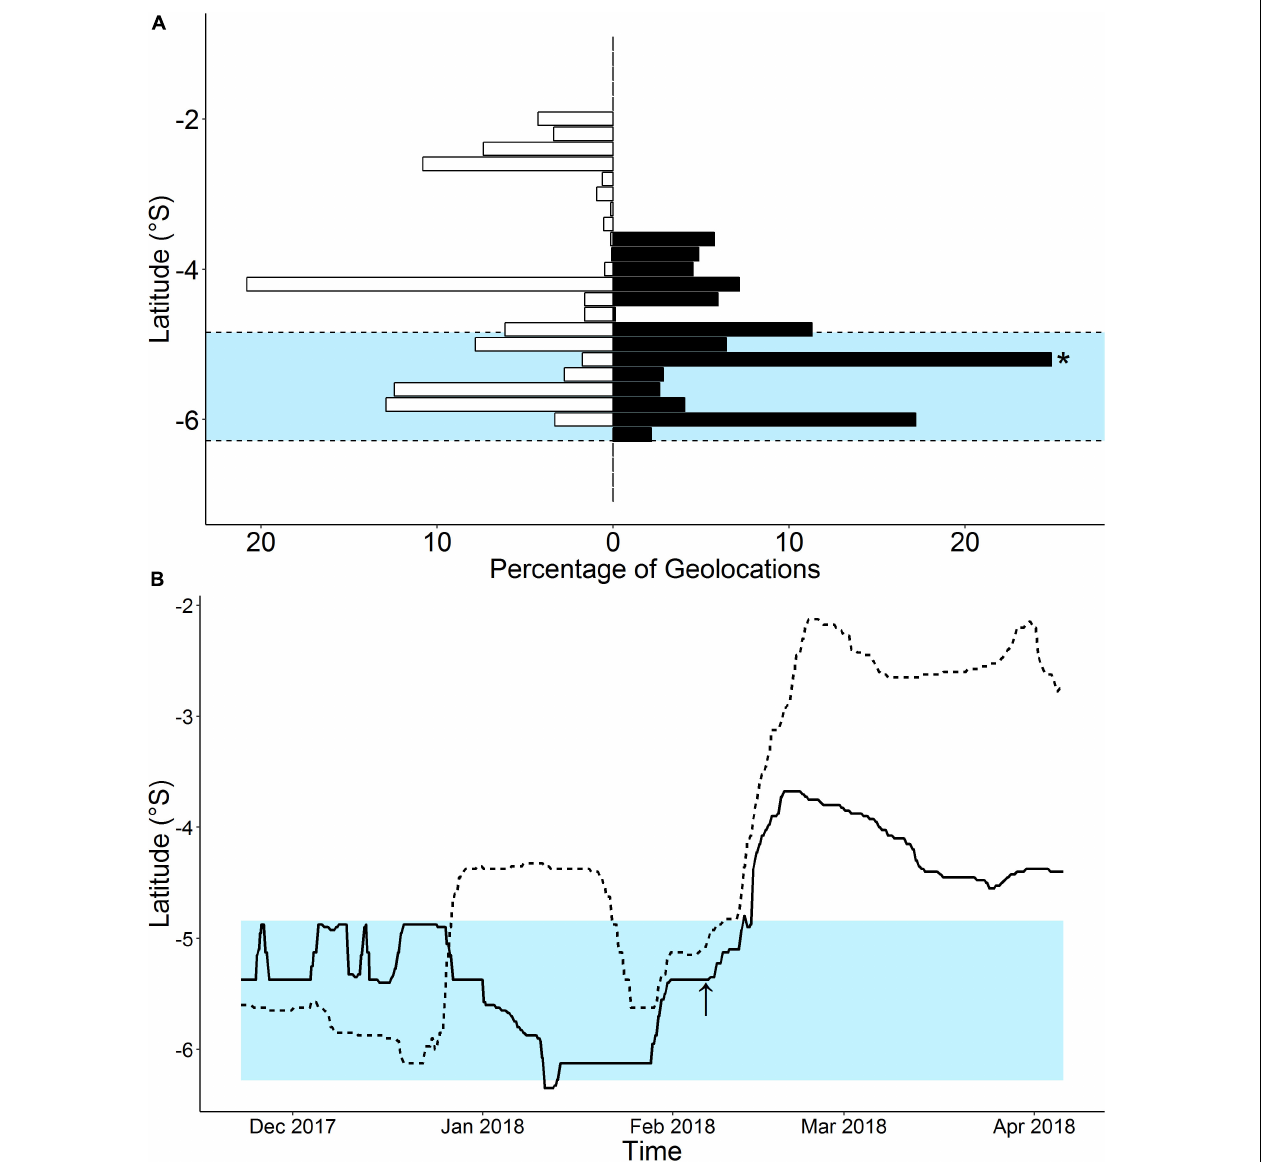
FIGURE 5 | Percentage of total latitude estimates calculated for a geo-located satellite track of a reef manta ray ( Mobula alfredi ; individual M5) in Seychelles by a hidden Markov model (HMM) considering either archived environmental data only (GPE3; white bars), or archived environmental data and 481 known locations retrieved from an acoustic receiver array (GPE3/A; black bars; A ). Asterisk represents longitude at tagging location ( − 5.409 ◦ S; D’Arros Island). Estimated latitude over time also presented (B) for HMM models with (GPE3/A; solid line) and without (GPE3; dashed line) acoustic data. Blue shading in both panels represents latitudinal range of the Amirantes Group. Arrow indicates time of last recorded acoustic detection of